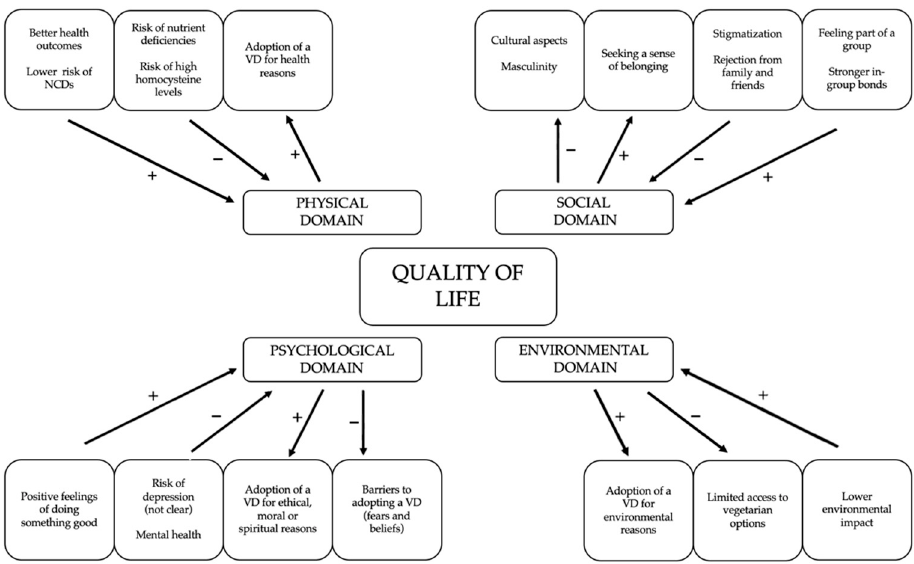
Figure 1. Connections between aspects of vegetarianism and quality of life domains. The arrows indicate the direction of the influence, that is, whether a given domain influences or is influenced by certain aspects of vegetarianism. The plus (+) and minus ( − ) symbols indicate positive and negative influences, respectively. NCD: noncommunicable diseases; VD: vegetarian diet.